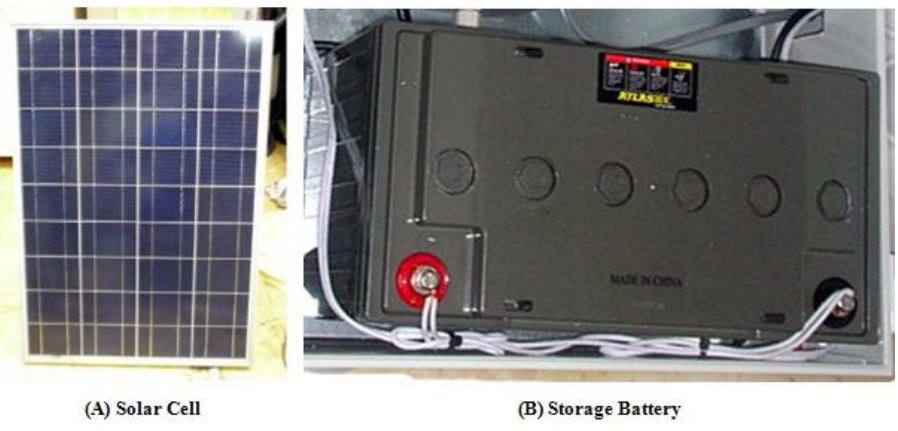
Figure 10. Solar Cell and Storage Battery.